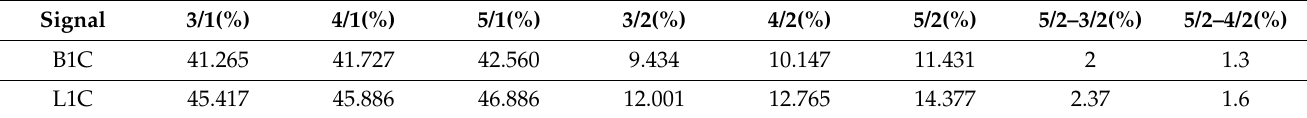
Table 6. The positioning accuracy improvement ratio in the ECEF coordinate